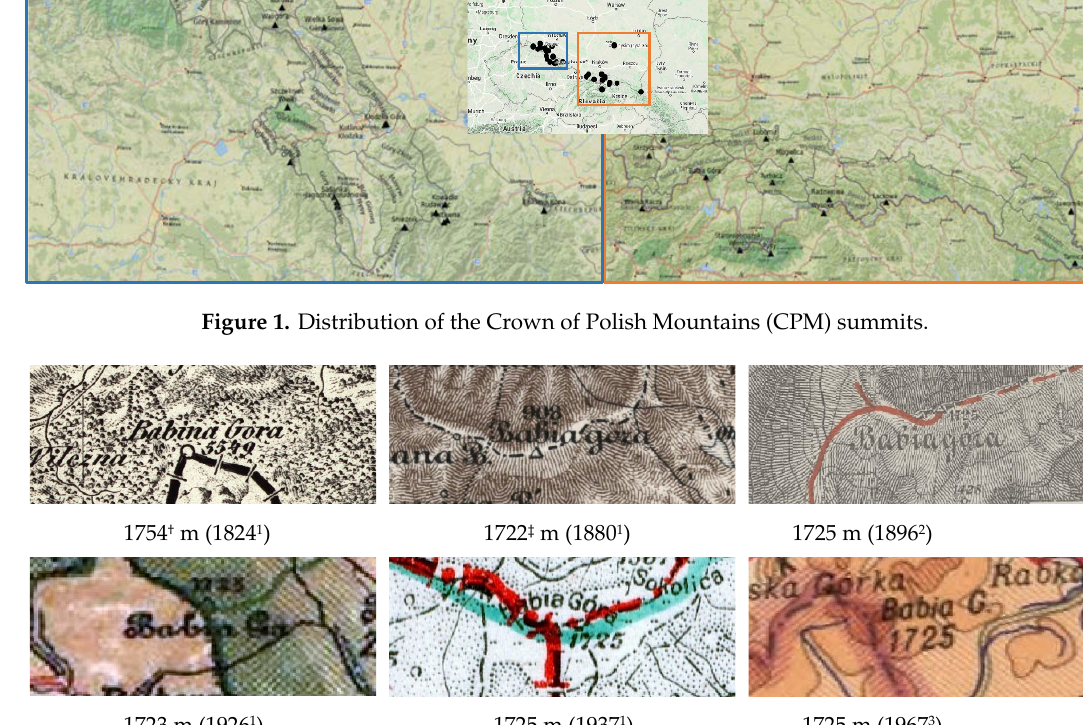
Figure 1. Distribution of the Crown of Polish Mountains (CPM) summits.